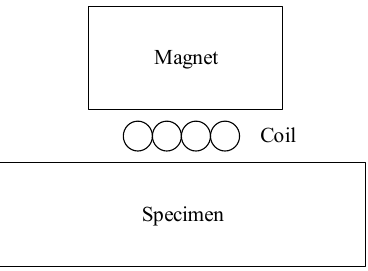
Figure 1. Typical configuration diagram of an electromagnetic acoustic transducers (EMAT).